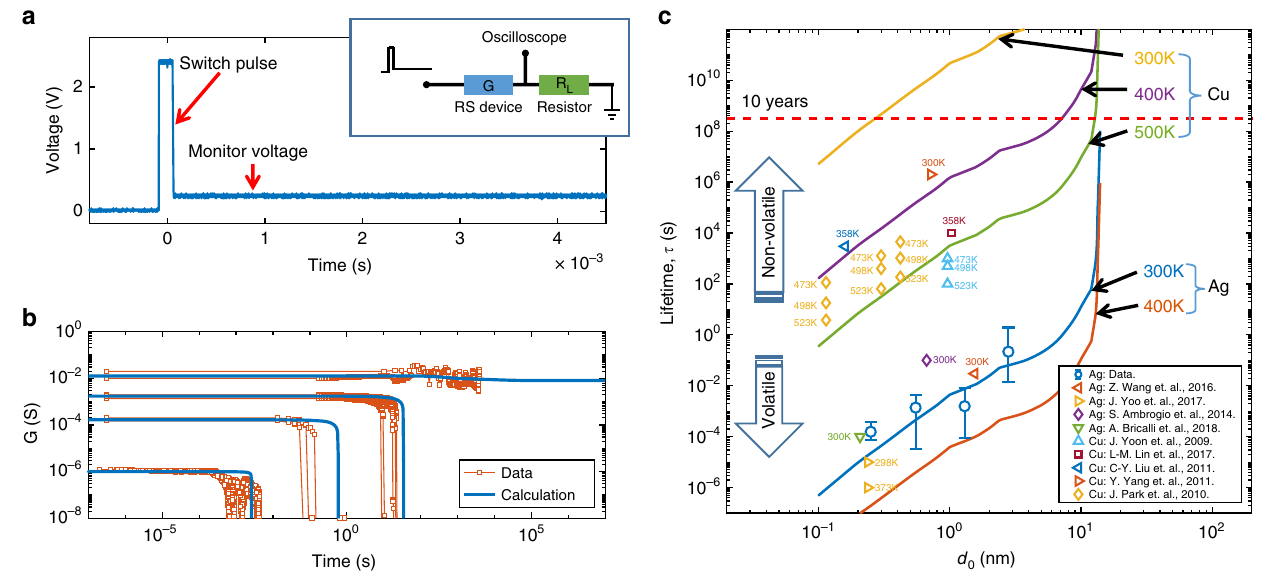
Fig. 5 Universal explanation for volatile and non-volatile switching. a Illustration of the experimental setup for the measurement of the lifetime of Ag fi lament. The Ag NWs resistive device with conductance G is serially connected with a load resistance R I L which limits the current to a maximum value C . A voltage pulse (2.5 V, 100 μ s) is applied to create the Ag fi lament, followed by a relatively low monitor voltage (0.1 V) to probe the fi lament evolution. b Measured and calculated conductance for the resistive switching device for different fi lament sizes. As I C increases, the lifetime of the Ag fi lament increases as a result of the size-dependent surface diffusion. The largest I C ~10mA results in a stable conductance, corresponding to a stable capillary bridge with a large diameter. c Measured and calculated CF lifetime for devices with electrode made of Cu 39 – 43 and Ag 17,23,44,45 as a function of the initial diameter d 0 . At room temperature, the parameter B was estimated as 10 − 34 m 4 /s and 10 − 47 m 4 /s for Cu and Ag fi laments, respectively. The values of the surface activation energy Q S was estimated as 1.1 eV and 0.52 eV for Cu and Ag, respectively. Calculations at various temperatures are also shown. The results account for the transition from volatile switching to non-volatile switching in RS devices (Fig. 1d – f) based on the size-dependent